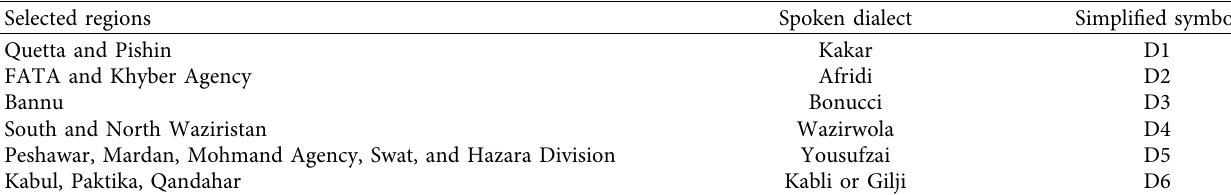
Table 2: Selected dialects with their respective regions of